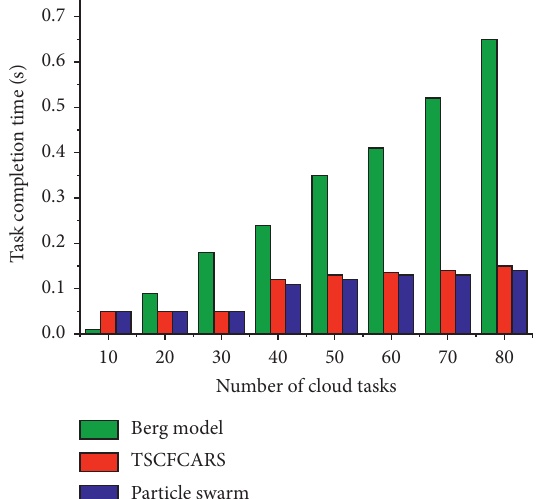
Figure 7: Comparison of completion time when cloud service execution is